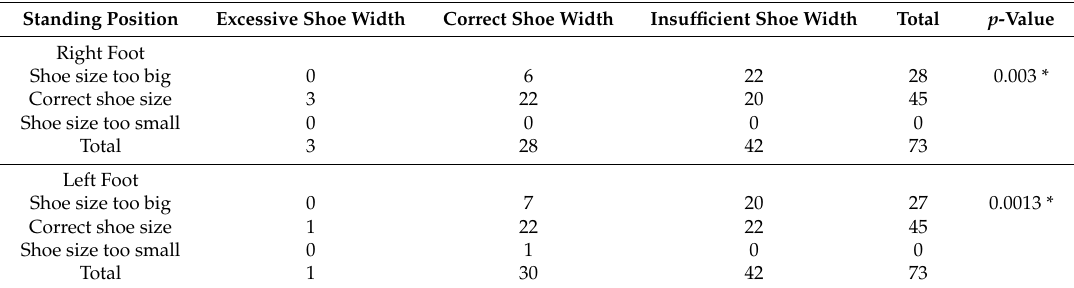
Table 2. Foot and shoe measurements (both feet, standing